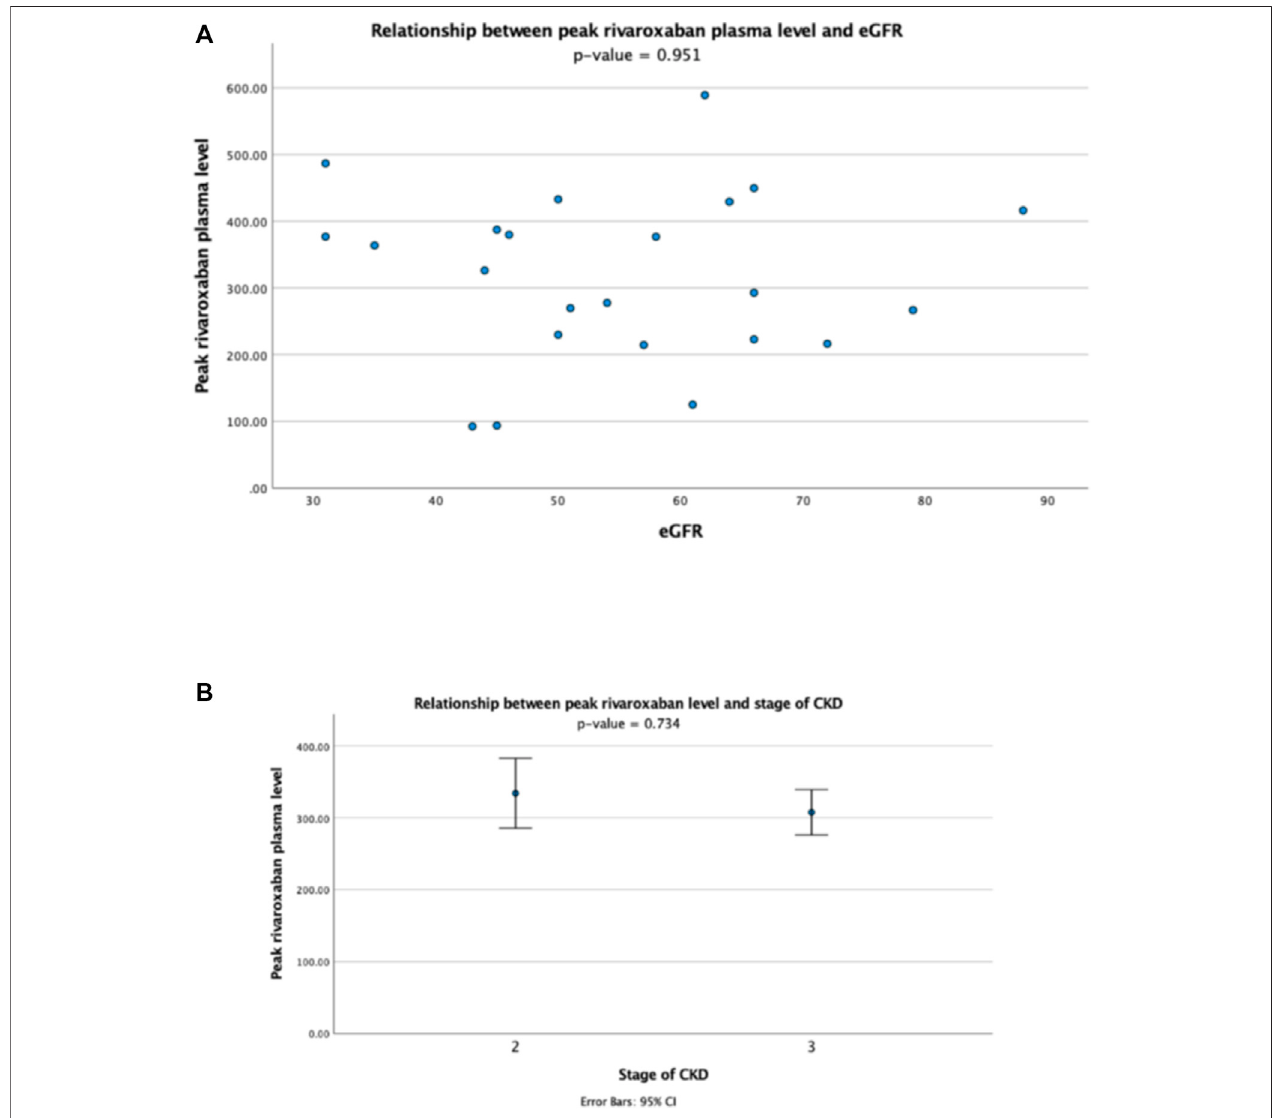
FIGURE 3 | Relationship between peak plasma rivaroxaban level and (A) eGFR and (B) stage of CKD in patients receiving rivaroxaban 15 mg once daily.